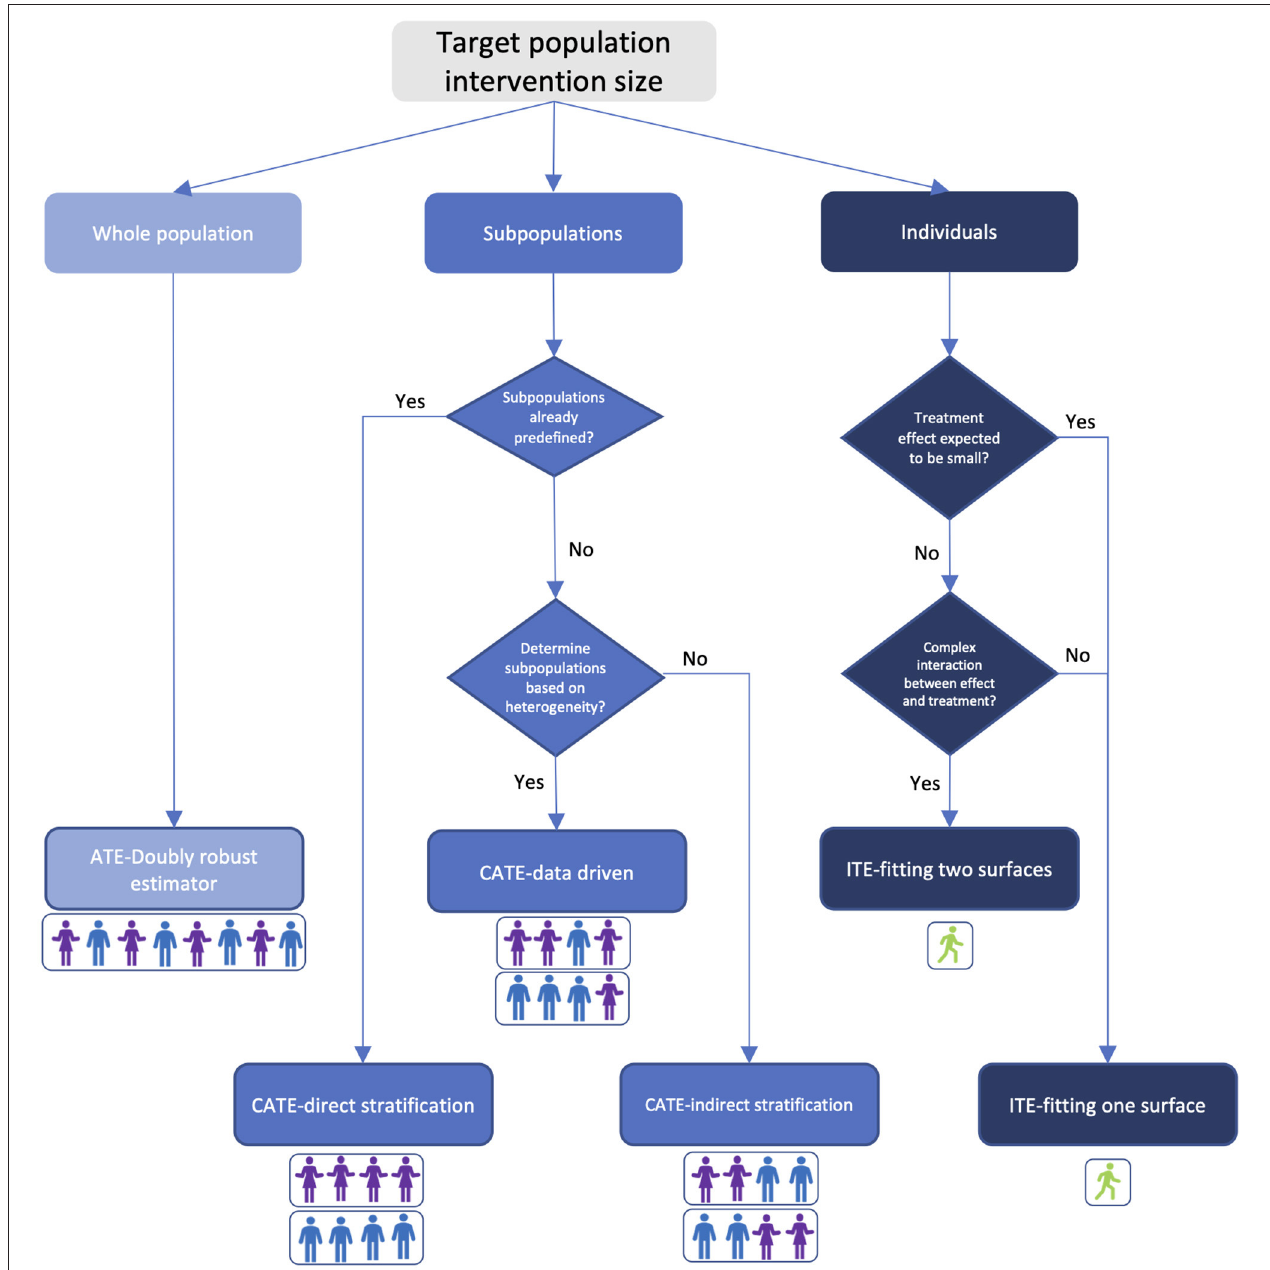
FIGURE 1 | Treatment effect estimator selection guide based on target-population intervention size and prior knowledge. Colors in the figure indicate bias-variance tradeoff. Light blue: high bias and low variance; blue: medium bias and variance; dark blue: low bias and high variance. Person icons under each estimator illustrate the composition of the targeted